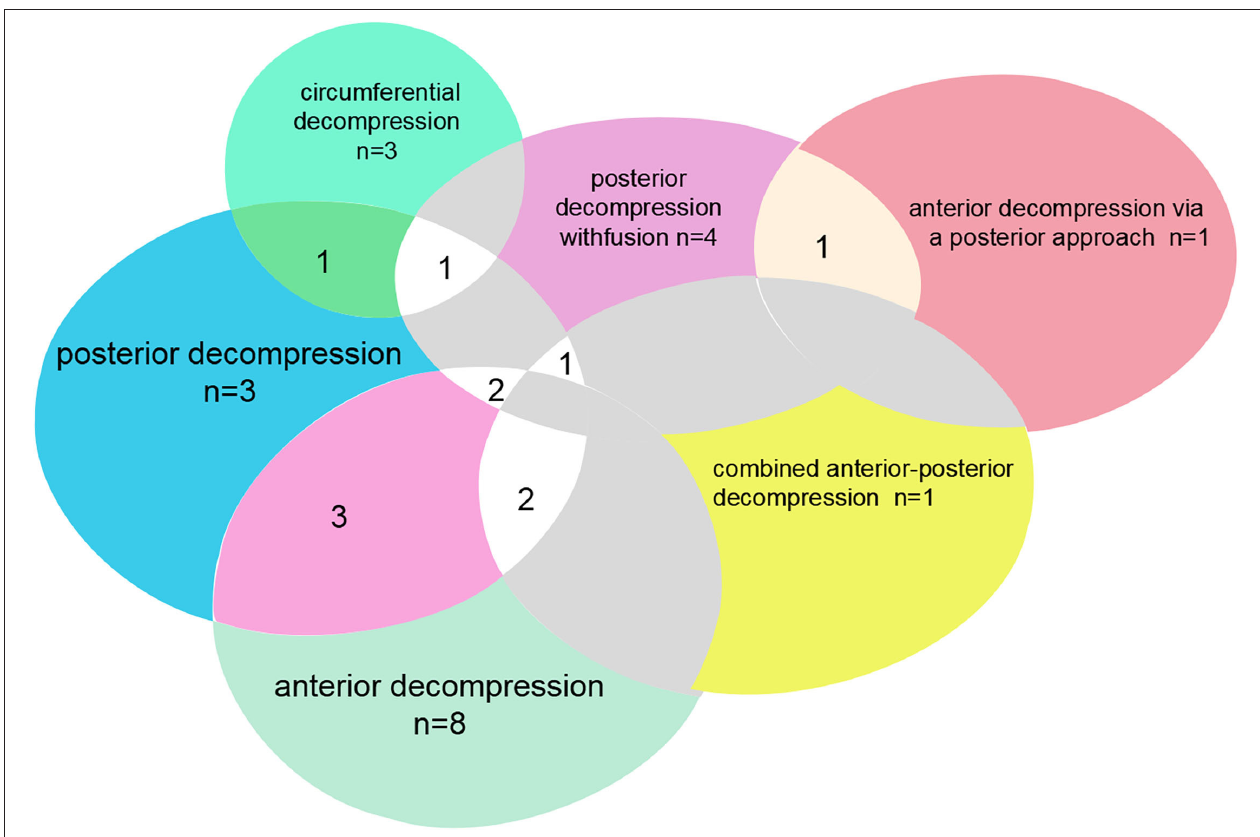
FIGURE 1 | Distribution and intersection points of the top 50 cited articles on surgical type on